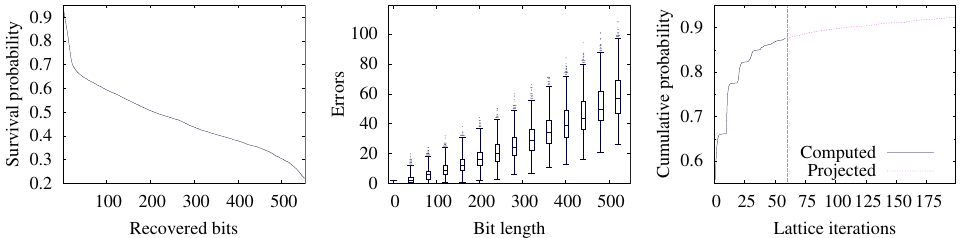
Figure 6: Left: bit recovery survival plot. Middle: number of errors successfully handled by our error correction algorithm. Right: Lattice iterations for successful instances. Table 3: Cluster computation effort in CPU minutes across phases and